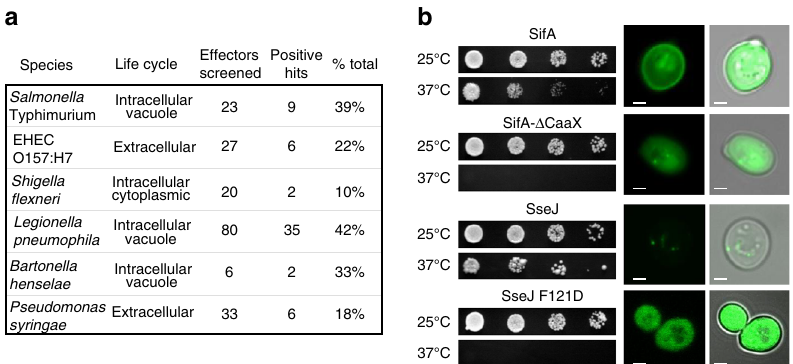
Fig. 2 Summary and validation of the Ras-rescue screen. a Table of results summarizing the pathogens studied, effectors screened, and percentage of effector repertoire from each pathogen that localized to eukaryotic membranes. b ( Left ) Ras-rescue screen of wild-type SifA (SifA, a SifA- Δ CaaX (mutation that removes the CaaX box from the C terminus of Sifa and no longer allows for prenylation), SseJ, or SseJ F121D (mutation that blocks binding of SseJ to membrane-bound RhoA). ( Right ) Micrographs of EGFP-tagged molecules with bright fi eld overlay on the right. Scale bar is 1